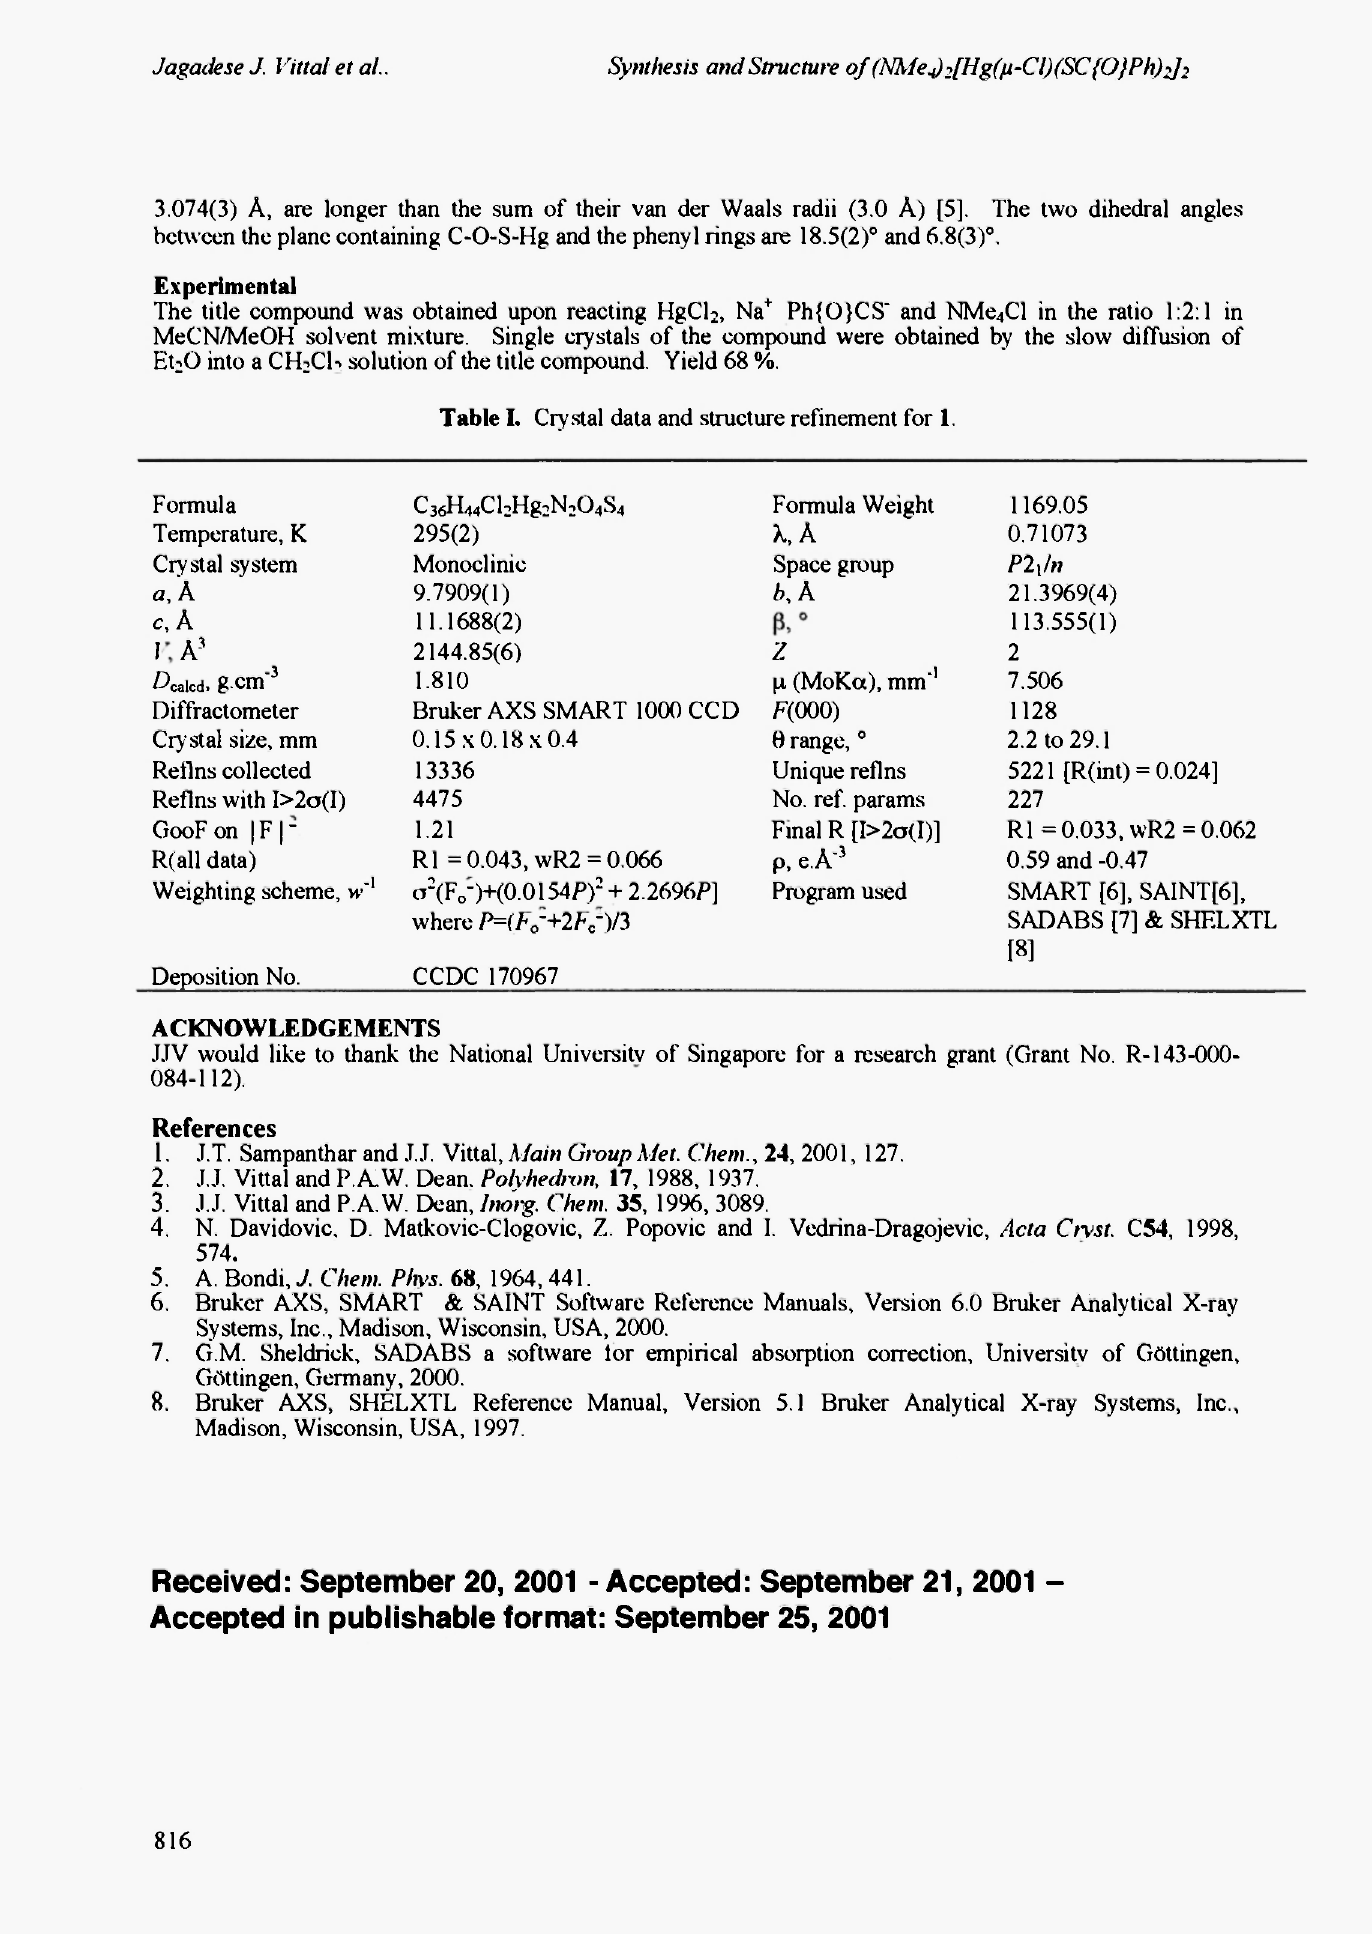
Table I. Crystal data and structure refinement for